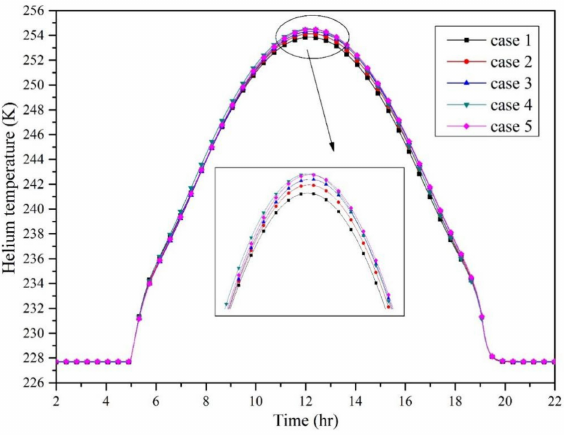
Figure 9. Helium temperature on the summer solstice.